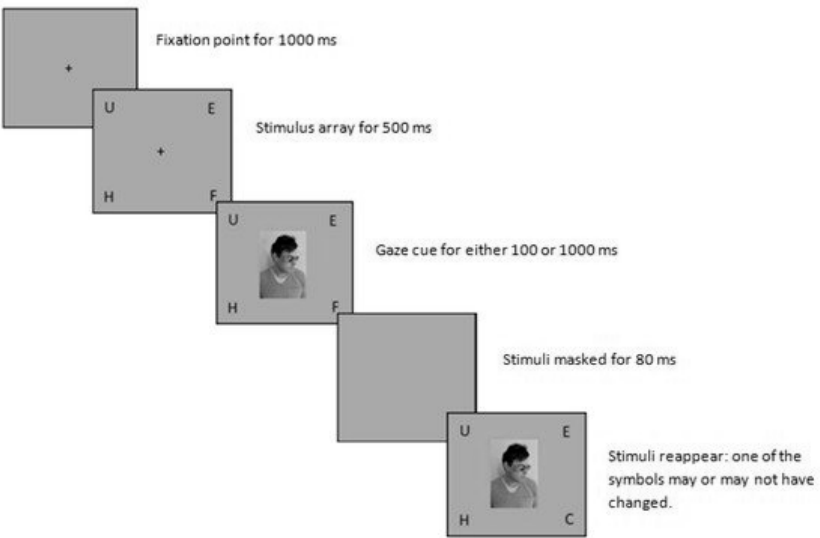
Figure 5. The experimental procedure employed by Morgan et al. [32].